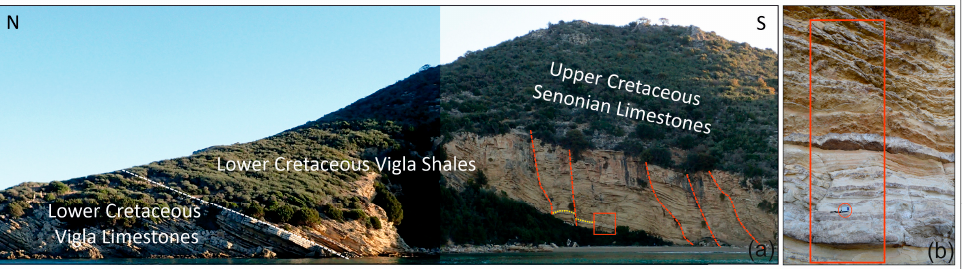
Figure 5. ( a ) The studied outcrop along the Araxos peninsula (Gianiskari coast) with the Lower Cretaceous “Vigla” shales overlying Lower Cretaceous “Vigla” limestones and underlying the Upper Cretaceous “Senonian” limestones (white dashed lines mark the two boundaries). Many normal faults cross-cut the sedimentary association of “Vigla” shales (red dashed lines) during sedimentation, producing synsedimentary slumps (white circle). Red box marks the position of ( b ).